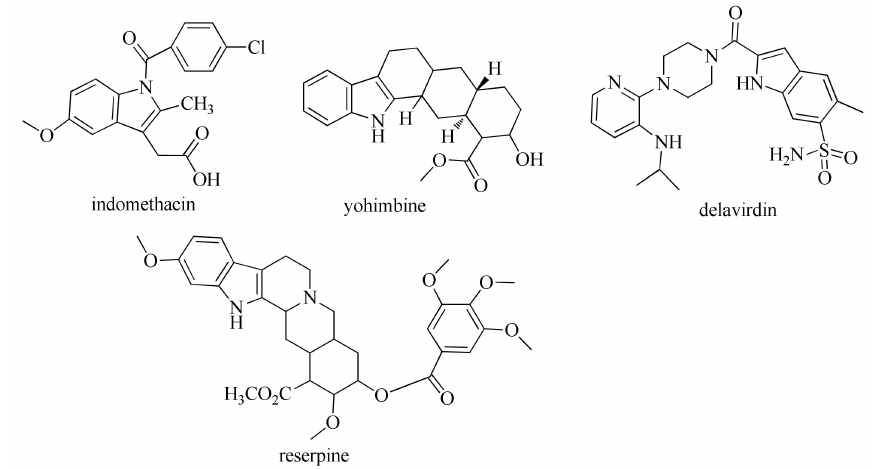
Figure 1. Approved drugs with indole